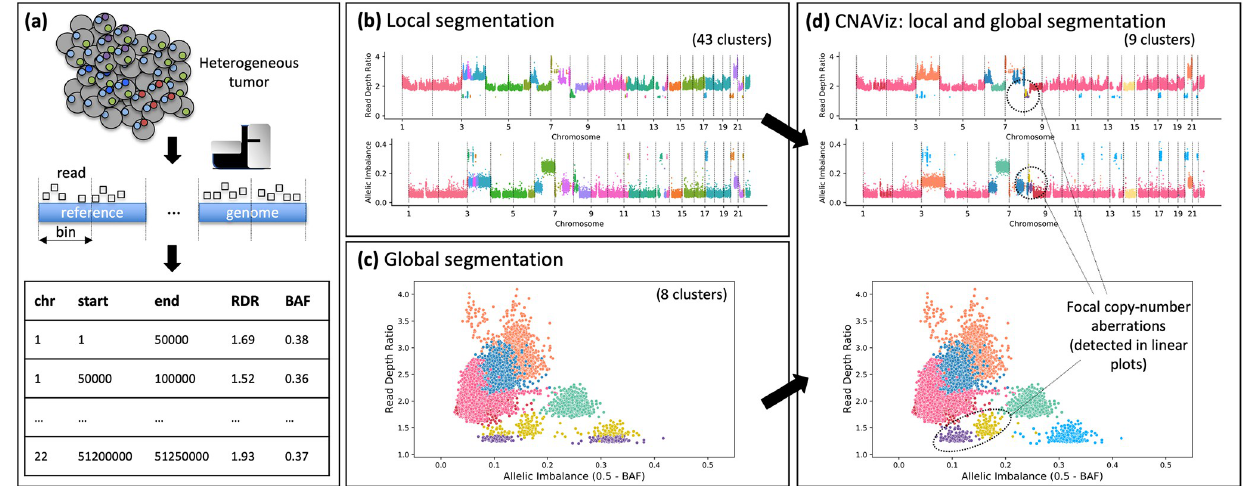
Fig 1. CNAViz enables user-guided segmentation for improved copy-number calling. (a) The genome of cancer cells (gray circles) is affected by CNAs (colored dots). DNA sequencing reads obtained from these cancer cells are aligned to a human reference genome, which is partitioned into bins (defined by the start and end position of the bin in a certain chromosome). For each bin, two signals are measured from DNA sequencing reads: the RDR, which is proportional to the total number of copies of the bin in the genome, and the BAF, which measures allelic imbalance. (b) Local segmentation algorithms combine neighboring bins with identical RDR (top plot) and BAF (bottom plot, where allelic imbalance is represented instead of BAF and is measured as 0.5 − BAF) into segments. Differences across datasets might lead to overclustering. (c) Global segmentation algorithms cluster bins with similar RDR and BAF values across the entire genome, disregarding genomic location information, which may lead to spurious clusters and omit focal CNAs. (d) CNAV IZ allows the user to unify local and global segmentation approaches to obtain a more accurate segmentation.